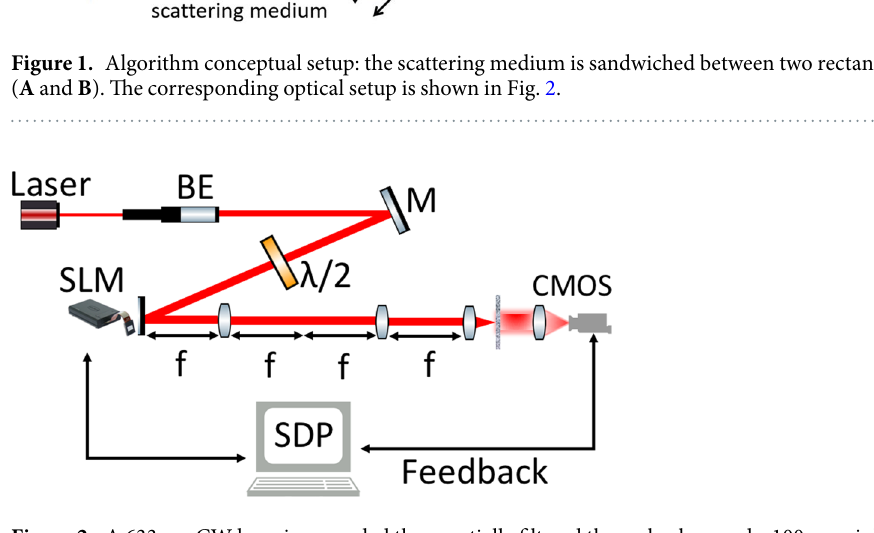
Figure 2. A 633 nm CW laser is expanded then spatially filtered through a lens and a 100 μ m pinhole (not shown). The polarization optics is placed before the SLM. The homogeneous beam is then reflected by the SLM that is 4 f imaged onto the sample. The resulting speckle pattern from the scattering sample is collected by a lens and imaged on the CMOS